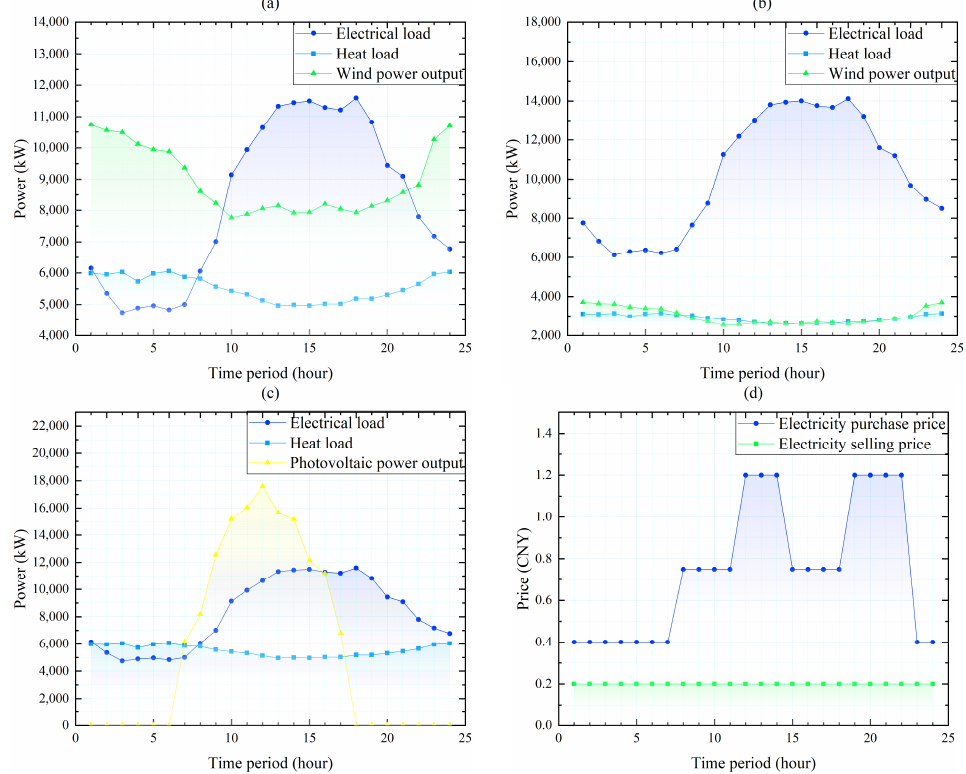
Figure 3. Basic source−load curves of the main bodies of each micro−grid. (a) Source−load curves of micro−grid ① . (b) Source−load curves of micro−grid ② . (c) Source−load curves of micro−grid ③ . (d) Electricity purchase and selling price of distribution grid.